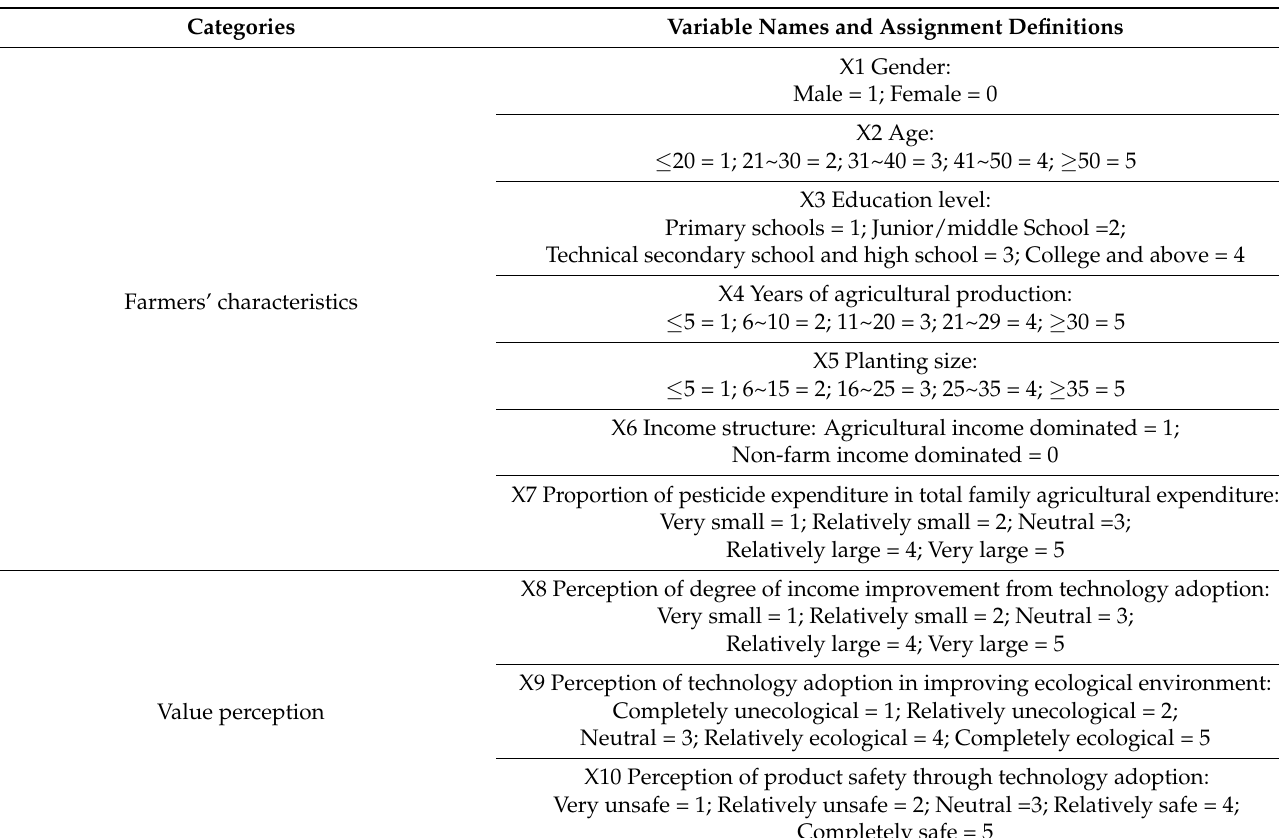
Table 2. Model variable definitions and